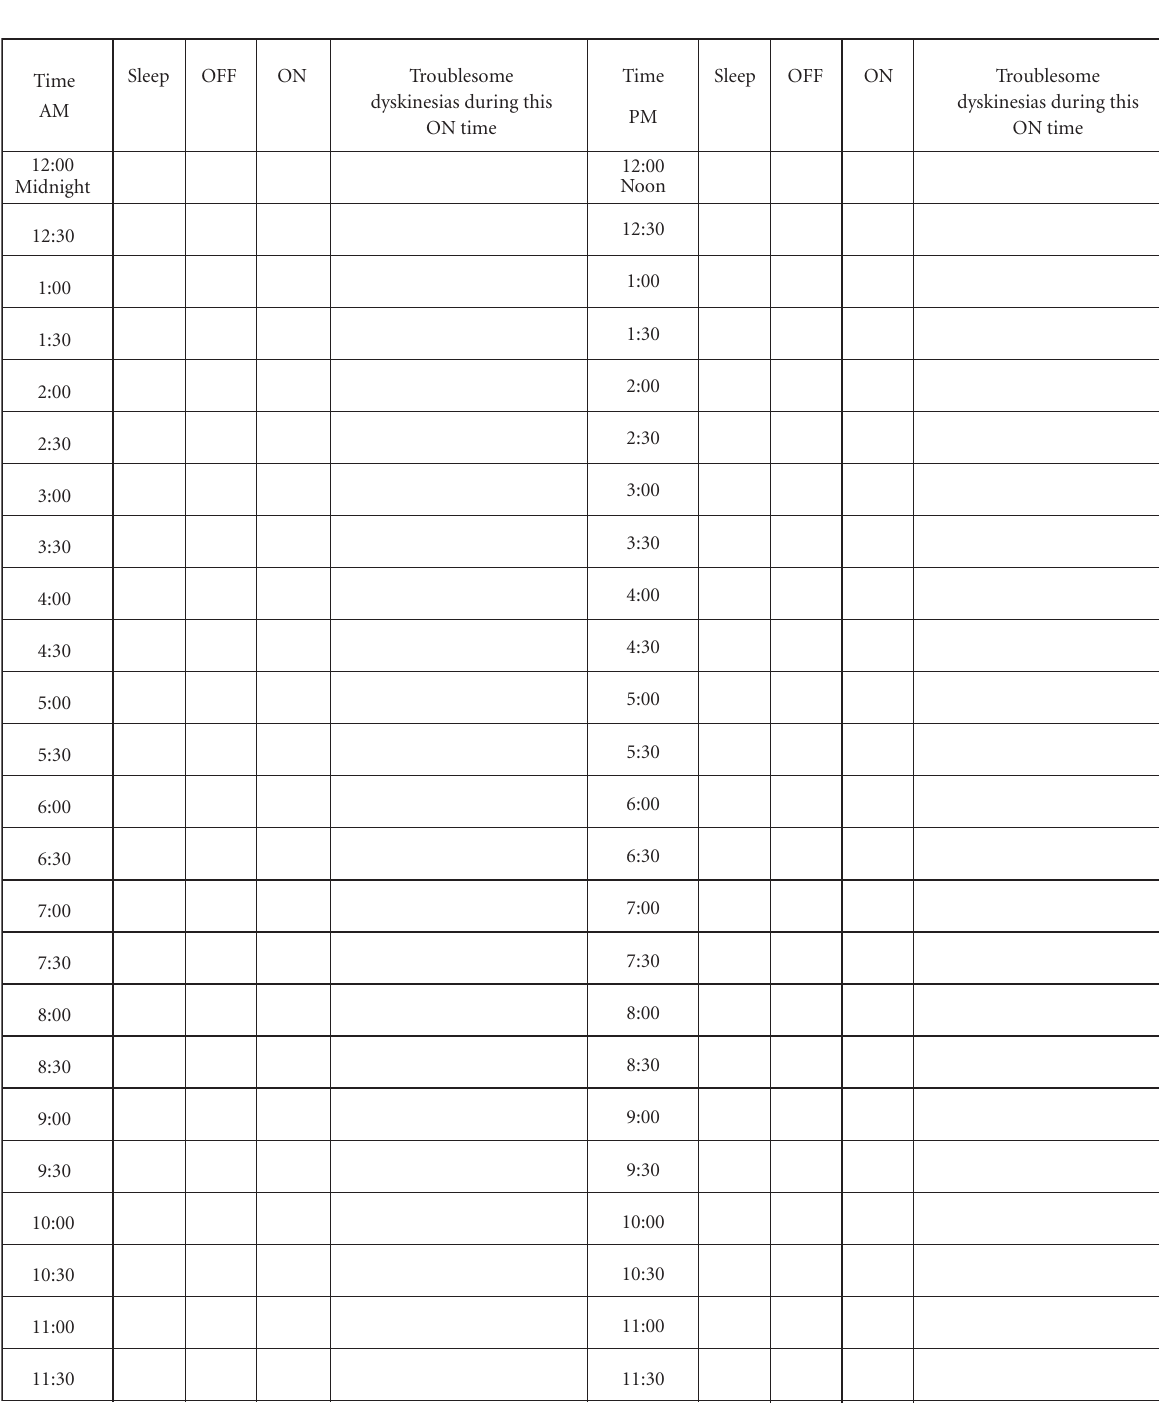
Figure 1: Blank diary